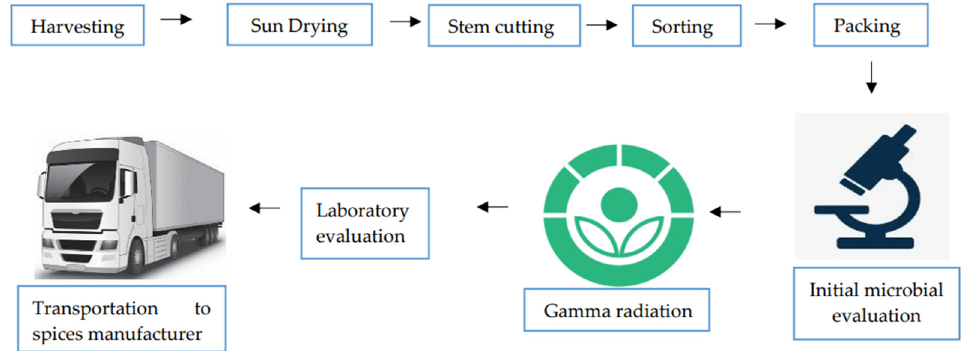
Figure 2. Diagram for dried chilli radiation process from